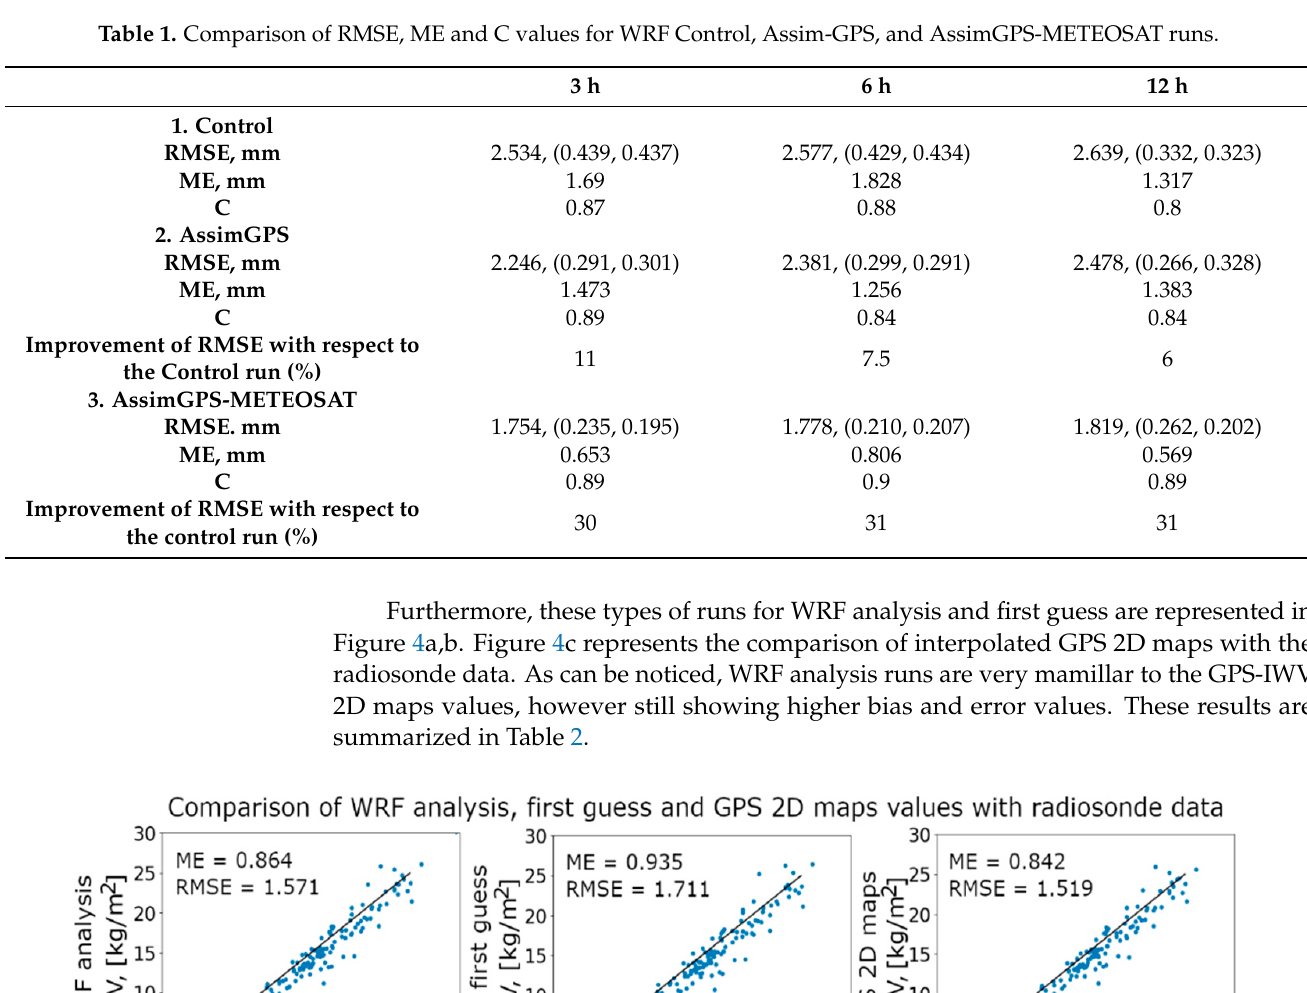
Table 1. Comparison of RMSE, ME and C values for WRF Control, Assim-GPS, and AssimGPS-METEOSAT runs.